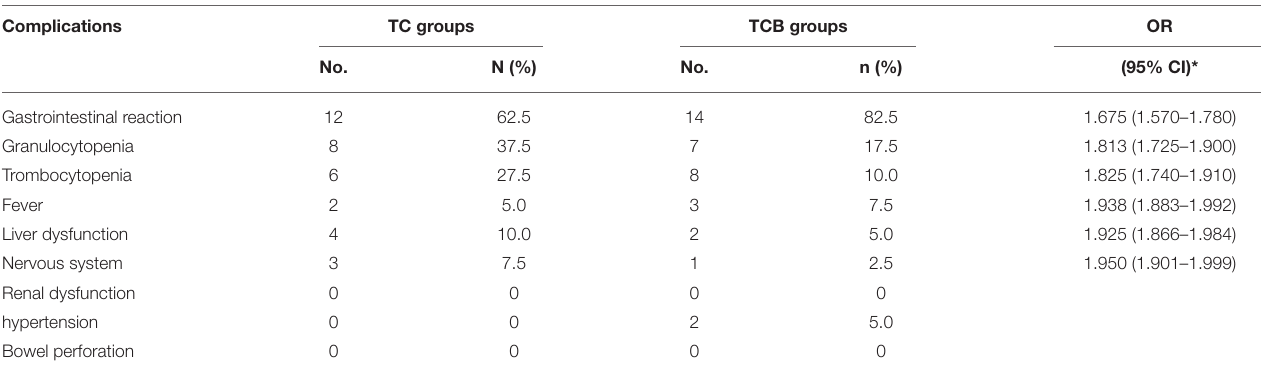
TABLE 4 | Chemotherapy complications of ovarian cancer